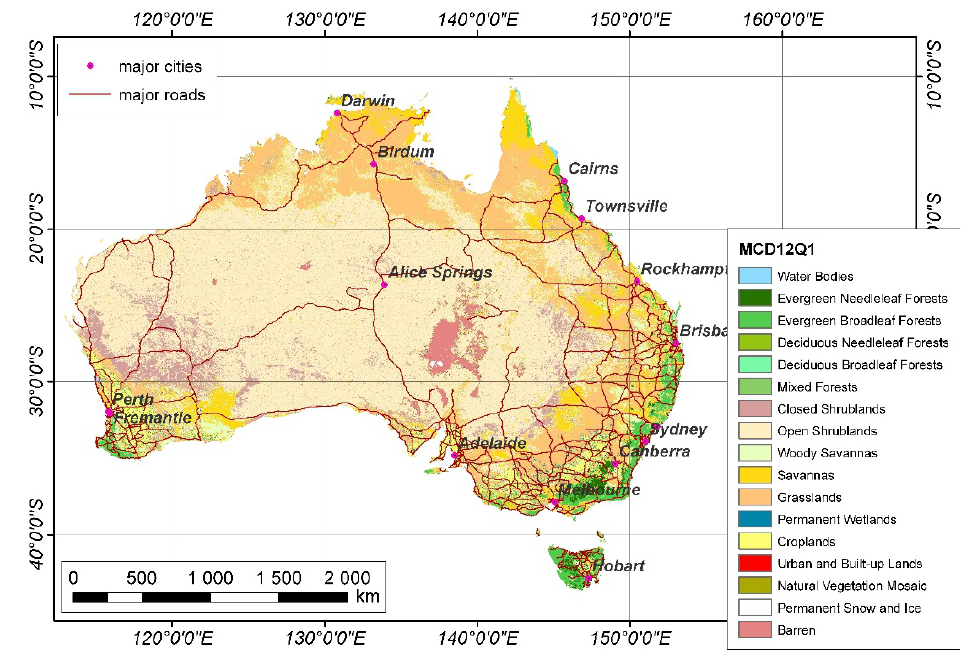
Figure 2. A MODIS land cover map (MCD12Q1, 2018), with a spatial resolution of 500 m, was presented for 17 classes of IGBP land cover classification. In addition, the major roads and cities were drawn.